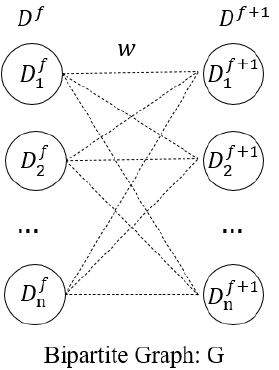
Figure 8. Bipartite graph ‐ matching model.